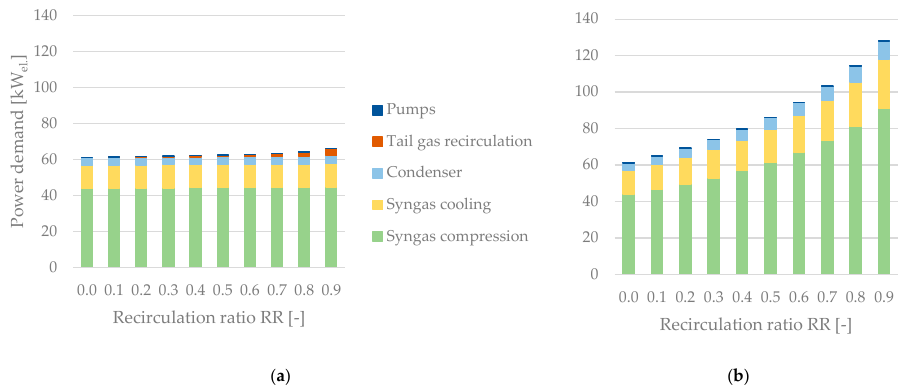
Figure 13. Power demand of auxiliary equipment excluding the SOEC unit as a function of the recirculation ratio—( a ) without a tail gas reformer, ( b ) with a tail gas reformer.